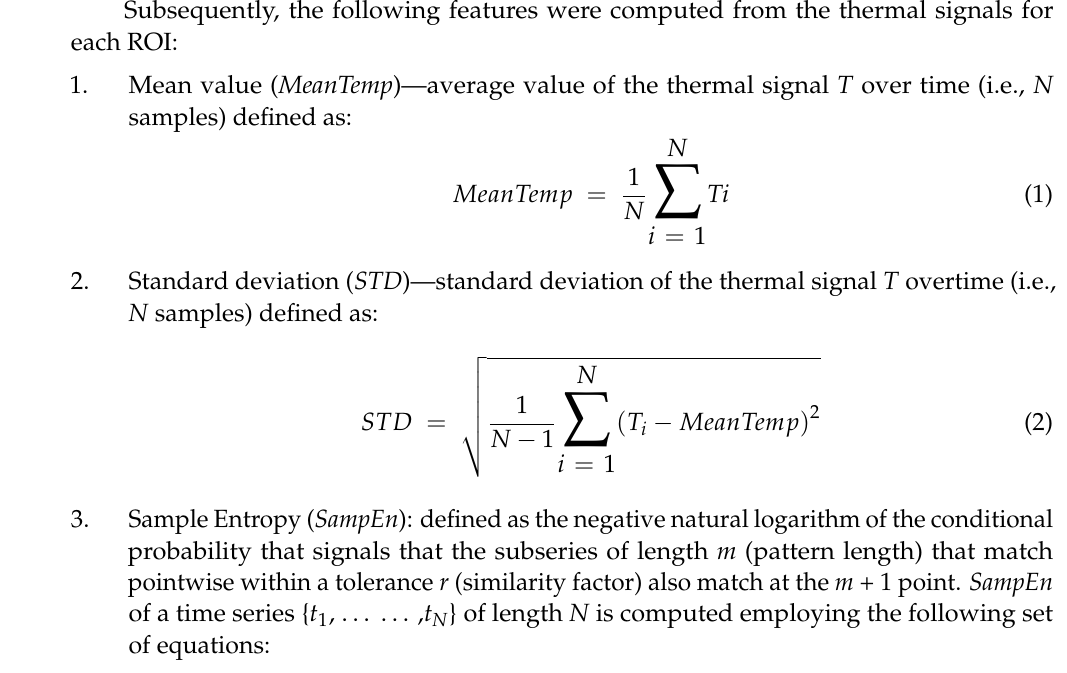
Figure 2. Thermogram of a representative participant with indicated and selcted ROIs over the tip of the nose and the corrugator. Thanks to a tracking algorithm, the ROIs were followed across the frames of the infrared video recorded, allowing to dynamically monitor the temperature time course of the selected ROIs. This approach allowed to evaluate linear and non-linear metrics indicative of the psychophysiological state of the participants.